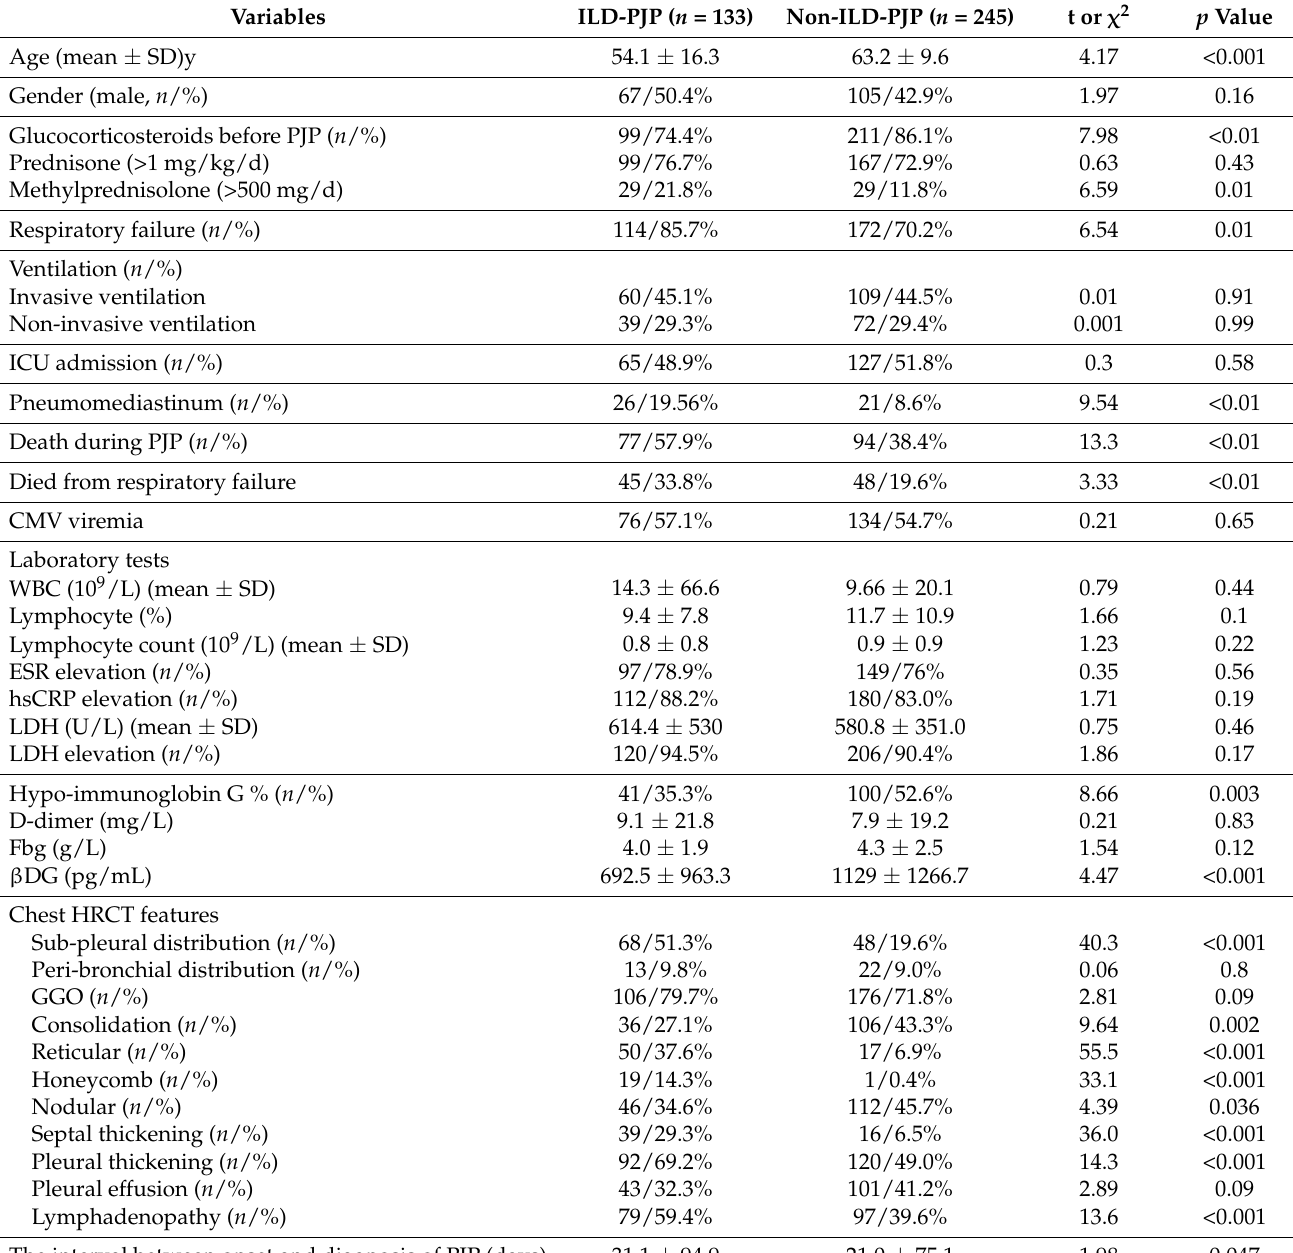
Table 2. The characteristics of ILD-PJP patients vs. non-ILD-PJP